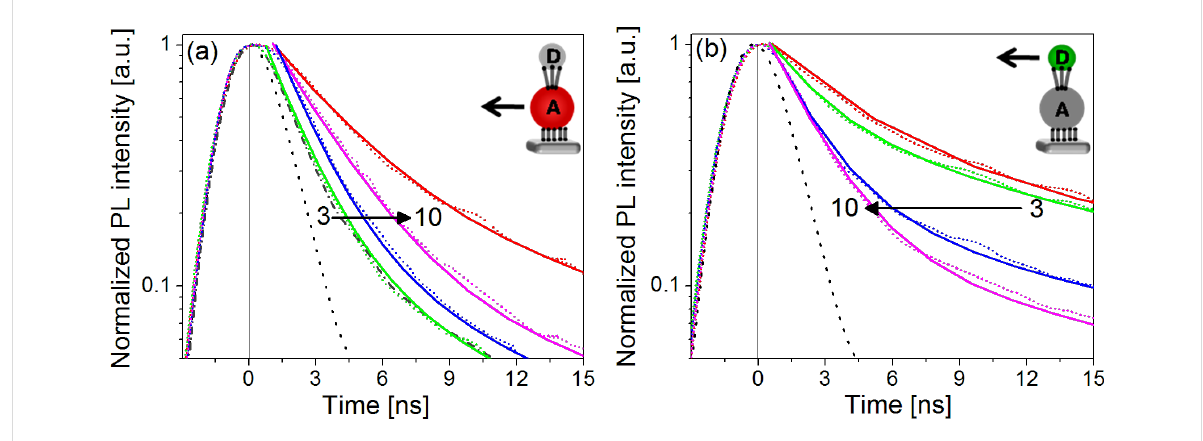
Figure 3: PL-lifetime measurements at 15 K of acceptor (a) and donor (b) NPs in the bilayer assemblies with various DT linkers (C 3 DT-green, C 6 DT- blue, and C 10 DT-magenta). The red curves represent control experiments of the PL-lifetime of a single NP monolayer of acceptors or donors, respect- ively. The lifetime of the acceptors coated with all types of DT is the same for all the linkers and is presented as a gray (dot–dash) curve in (a). We do not observe any change in the lifetime of the DT coated acceptor, since it is beyond the time resolution of the measuring setup. The dotted curves are the raw data and the solid ones are the three exponential fittings. The system response at the laser wavelength (460 nm) is represented by the dotted black curve. The intensities were normalized.